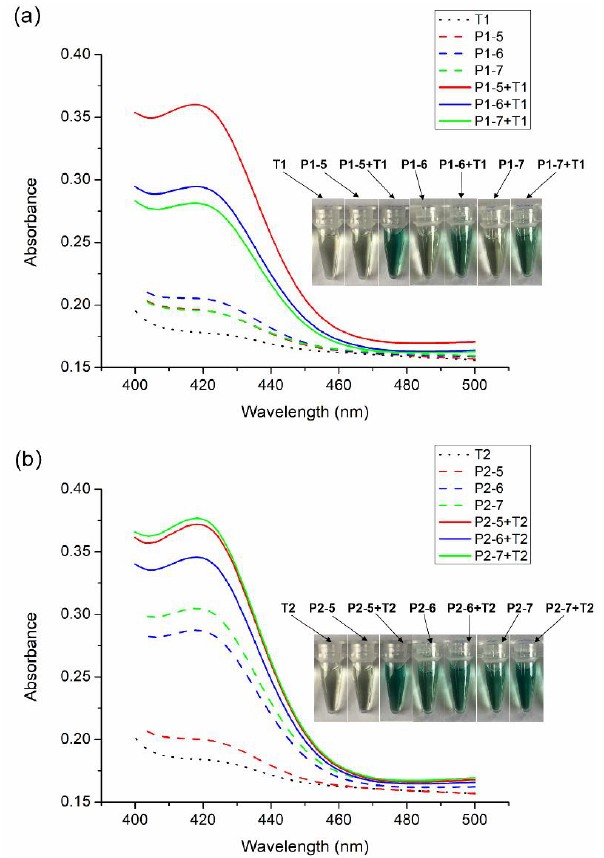
Figure 3. The UV spectra and colorimetric photograph (inner panel) of the individual probes ( a ) P1 and ( b ) P2 with different stem lengths (5, 6 and 7 bp) in the absence or presence of the corresponding targets. Conditions: 2 μM for each of the probes or targets, 20 mM MgCl 2 , 100 mM NH 4 Cl, 100 mM Tris-HCl (pH 7.4), 2 μM hemin, 4 mM H 2 O 2 , and 4 mM